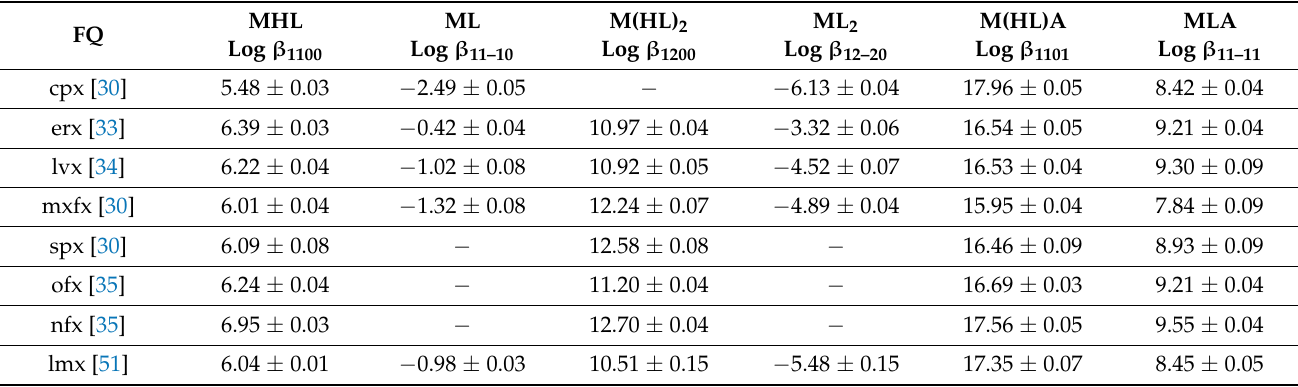
Table 1. Stability constants of Cu(II) complexes (determined at 25 ◦ C, I = 0.1 mol dm − 3 NaCl) ± error majorant, from